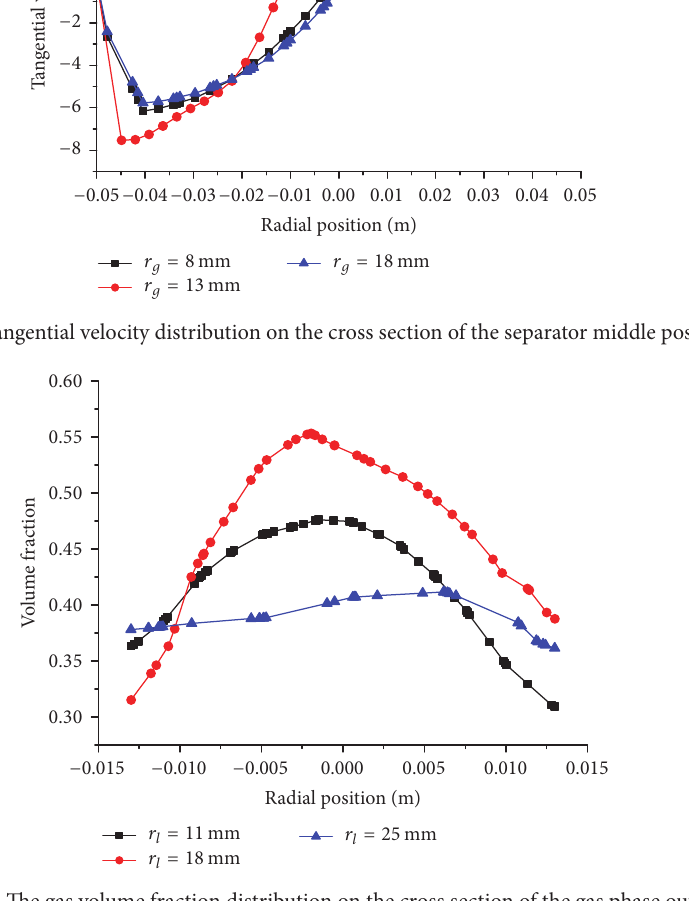
Figure 10: The gas volume fraction distribution on the cross section of the gas phase